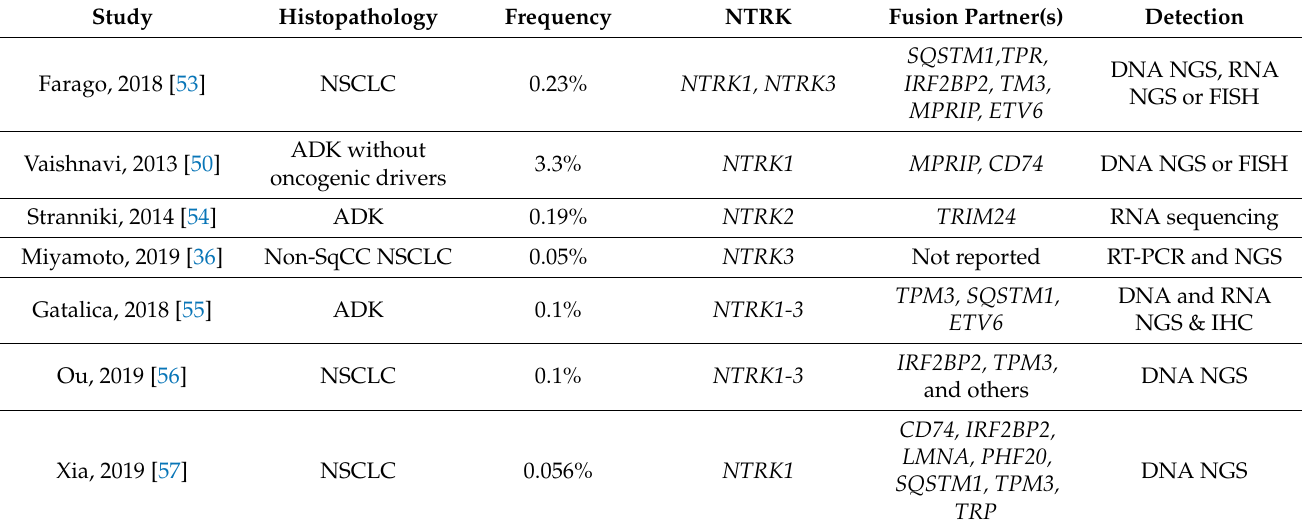
Table 5. Reported frequency of NTRK gene fusions in NSCLC.